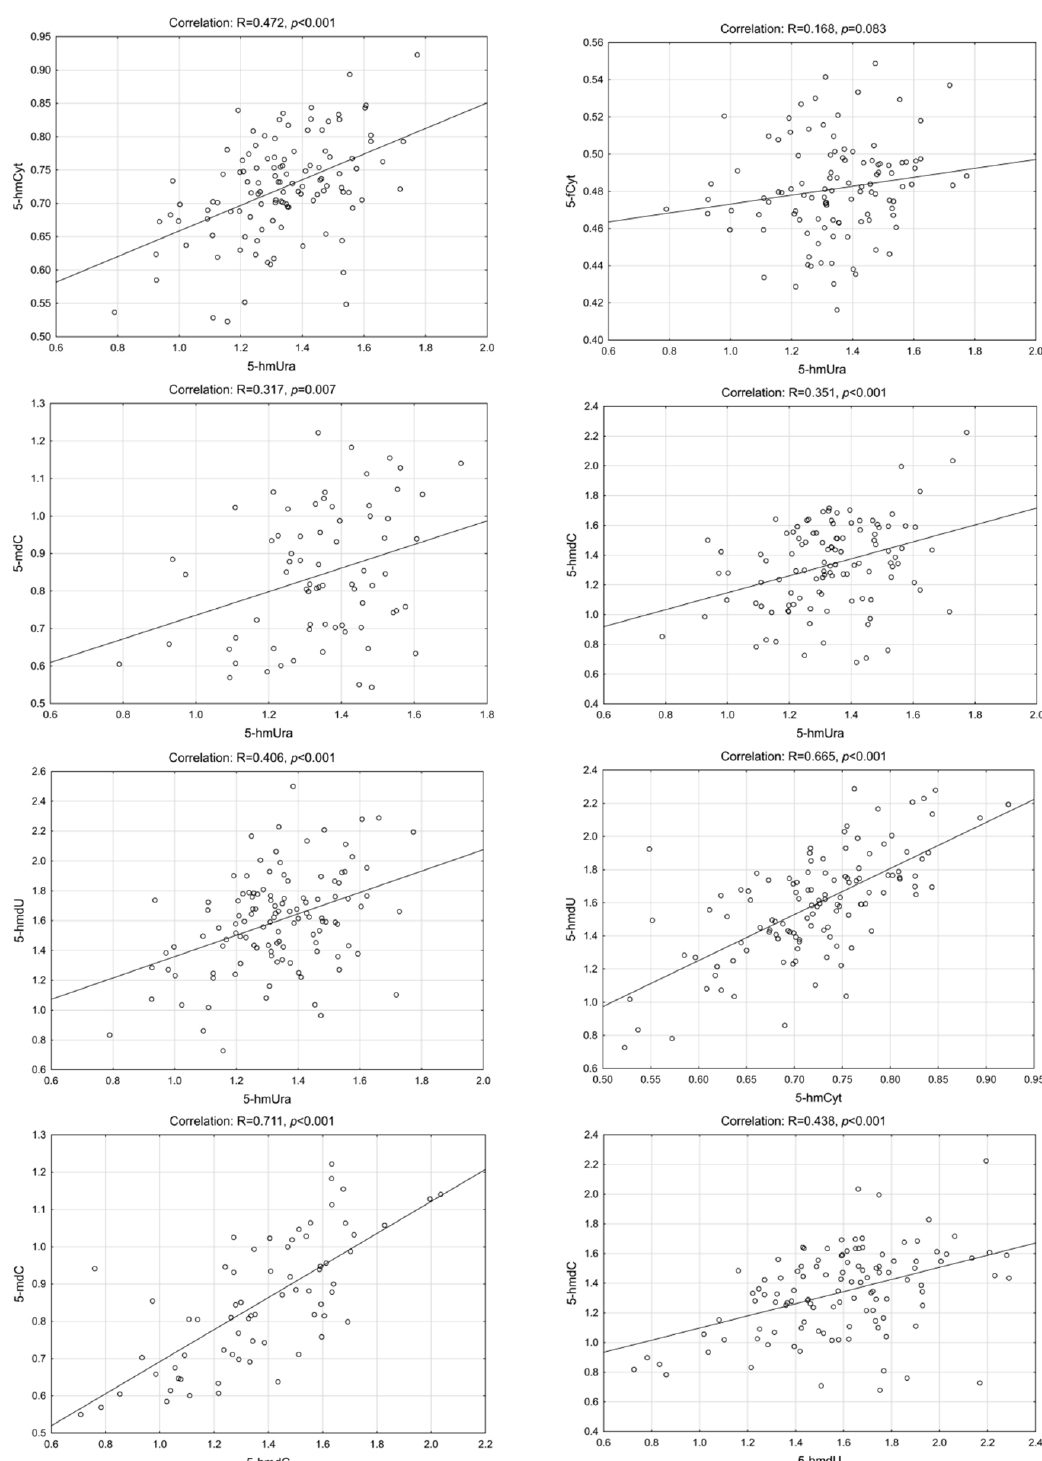
Figure 3. Selected correlations between the levels of DNA epigenetic modifications in urine— colorectal cancer group. 5-hmCyt: 5-hydroxymethylcytosine; 5-hmUra: 5-hydroxymethyluracil; 5-mdC: 5-methyl-2′-deoxycytidine; 5-hmdC: 5-(hydroxymethyl)-2′-deoxycytidine; 5-hmdU: 5-(hydroxymethyl)-2′-deoxyuridine; 5-fCyt: 5-formylcytosine.